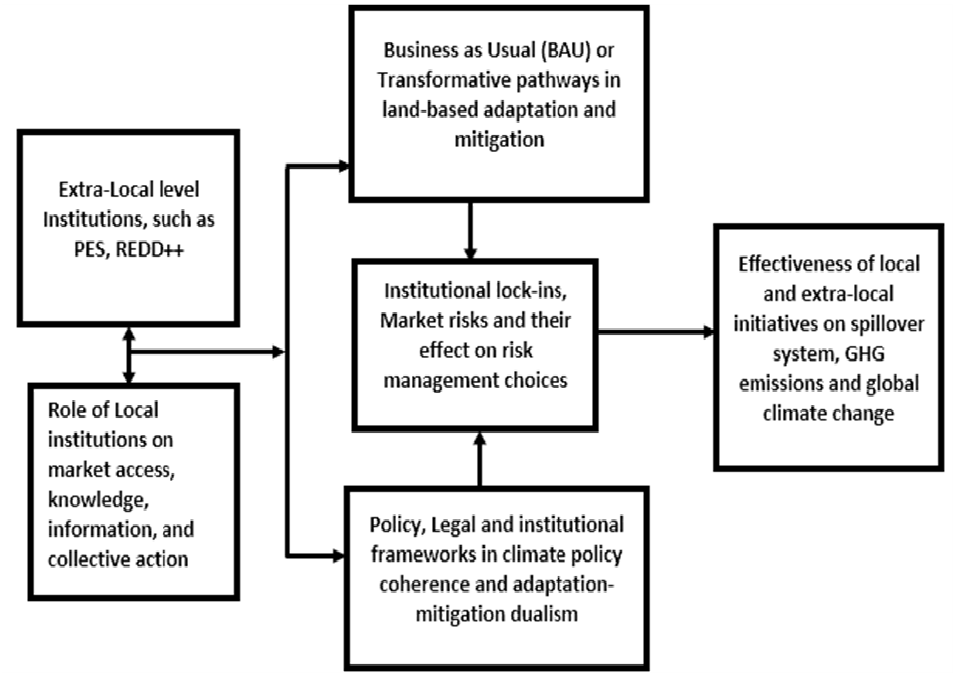
Figure 1. A conceptual framework on role of risk on environmental externalities.